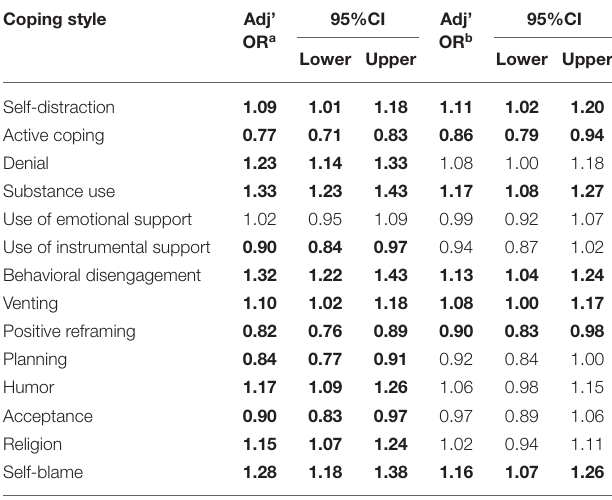
TABLE 3 | Multivariate logistic regression analyses of the association between copying skills and suicidality (suicidal vs. non-suicidal) adjusted for sociodemographic factors and mental